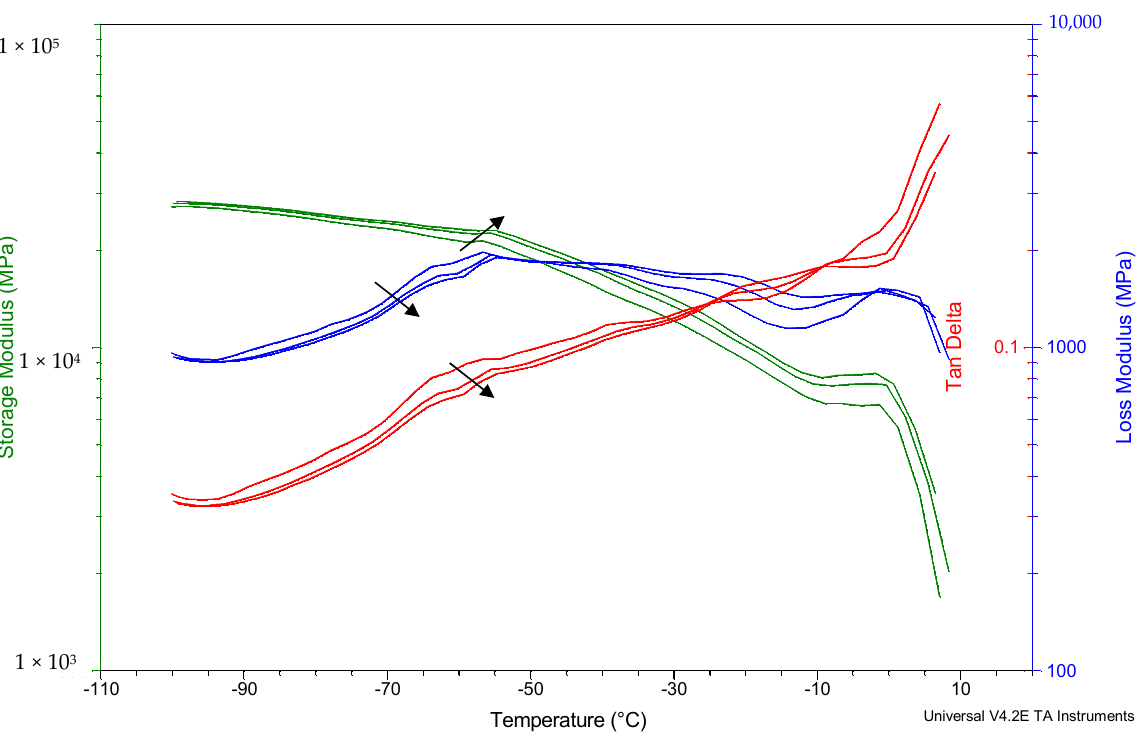
Figure 4. Storage modulus (E ′ ), loss modulus (E ″ ) and tan δ of wheat dough at 1, 5, 10 Hz obtained by DMA. The arrow goes from low (1 Hz) to high frequencies (10 Hz). Table 2. Glass transition temperature (Tg) and β -relaxation obtained from loss modulus curves at 1 Hz. Time of Dough Formulation